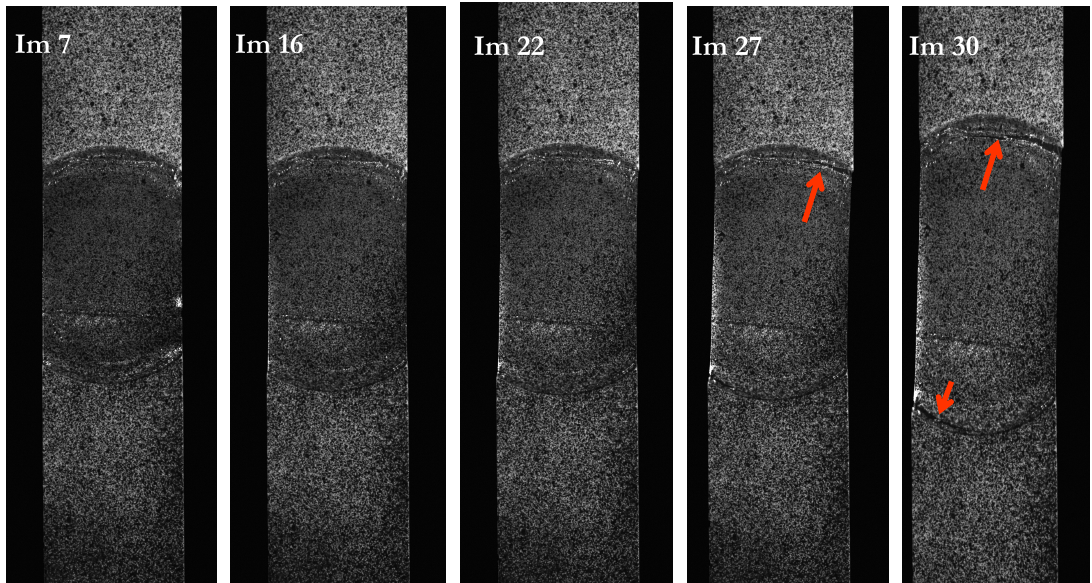
Figure 3: Sequence of digital images showing crack appearance and evolution during the